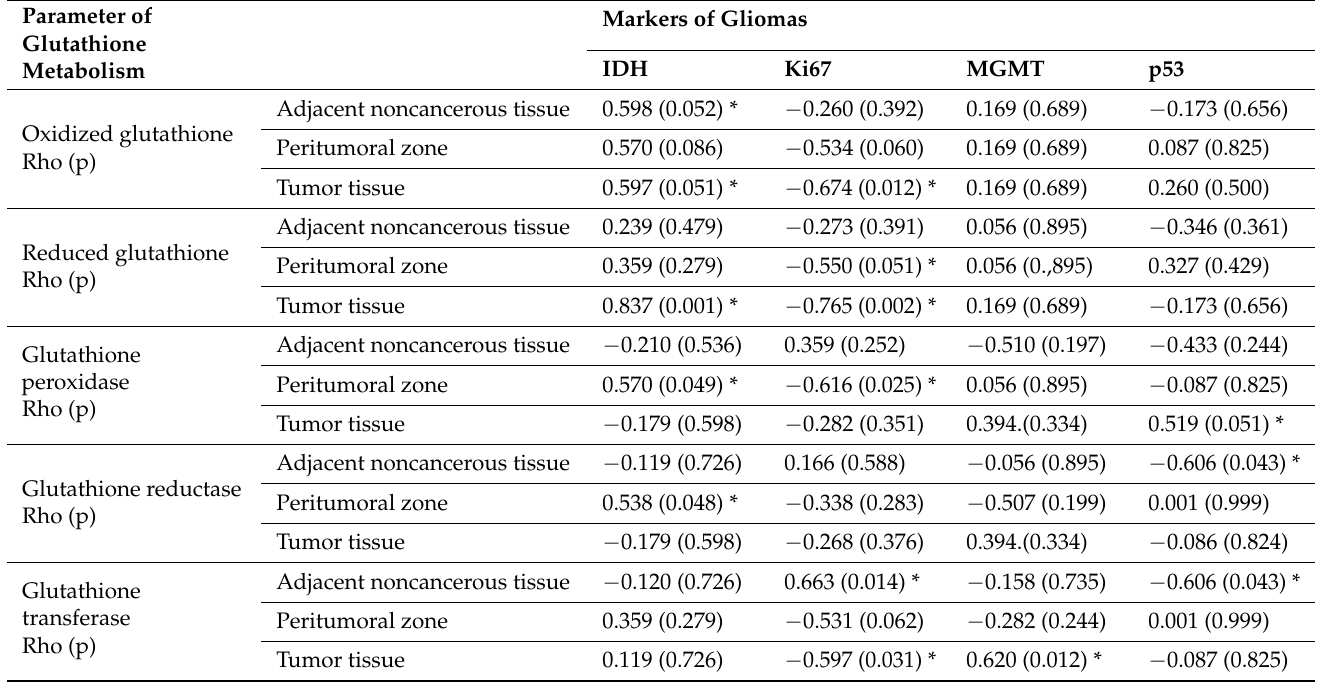
Table 3. Correlations (Spearman’s coefficient) between the immunohistochemical markers of gliomas and the parameters of glutathione metabolism of brain tumors in 20